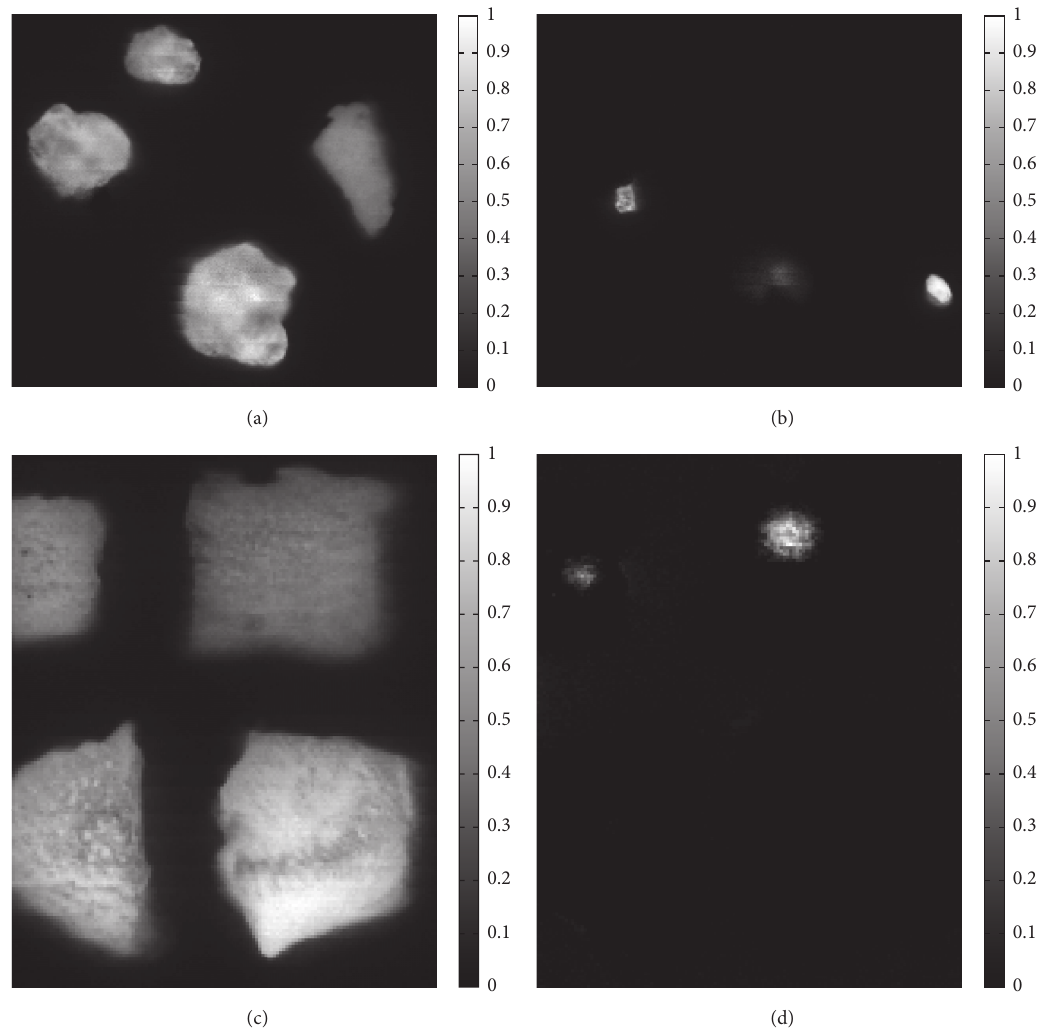
Figure 3: The detection results of soybean and melamine of Set A samples using CLS algorithm: (a) soybean image of Set A-1; (b) melamine image of Set A-1; (c) soybean image of Set A-2; (d) melamine image of Set